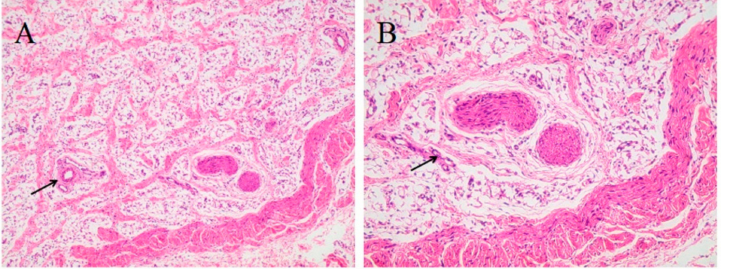
Figure 2. Morphological characteristics of piglet’s SAT by H&E staining. ( A ) The image magnified (10 × ). ( B ) The image magnified (20 × ). Arrows suggest SVF in